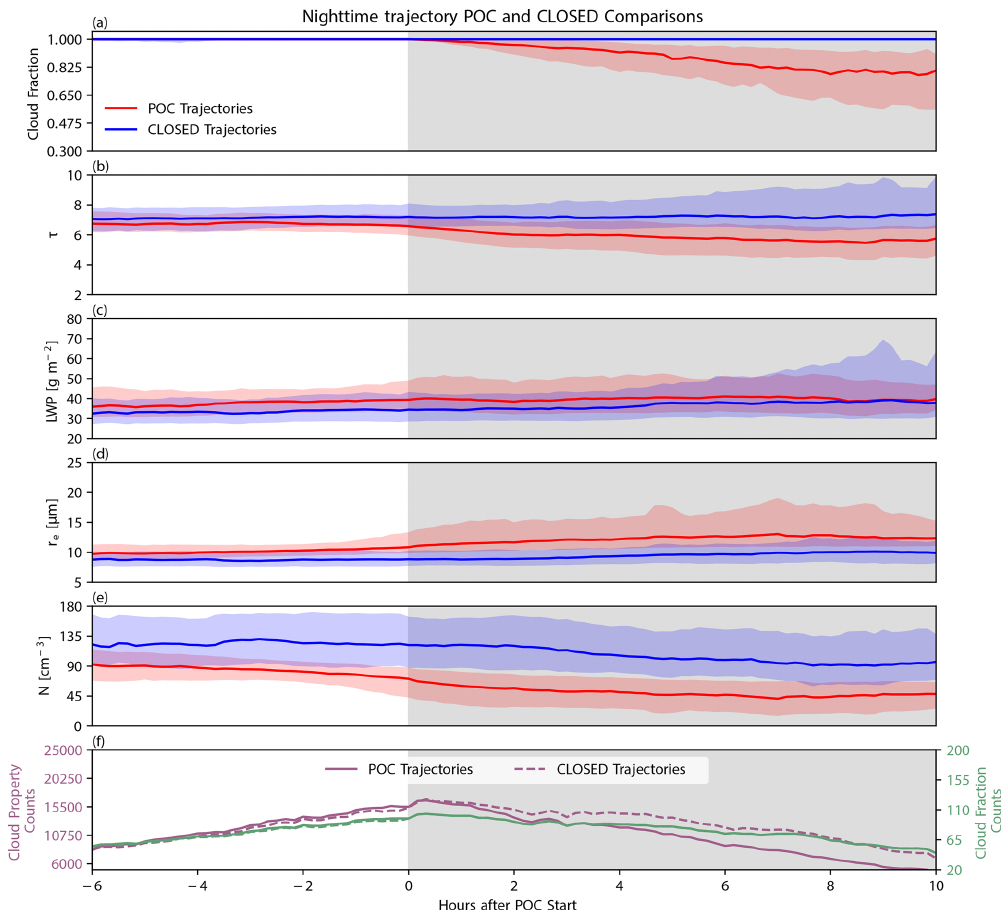
Figure A1. The median changes in nighttime cloud fraction (a) , cloud optical depth (b) , liquid water path (c) , effective radius (d) , and cloud drop number concentration (e) for the 6h before until 10h after POC development are shown along all pocket of open-cell stratocumulus (POC shown in red) and comparison (CLOSED shown in blue) trajectories, where the red and blue fill represent changes in the interquartile range. The number of valid samples for both the GOES-16 microphysical properties (purple) and GOES-16 cloud fraction (green) are shown in (f) . Gray shading indicates the time after POC